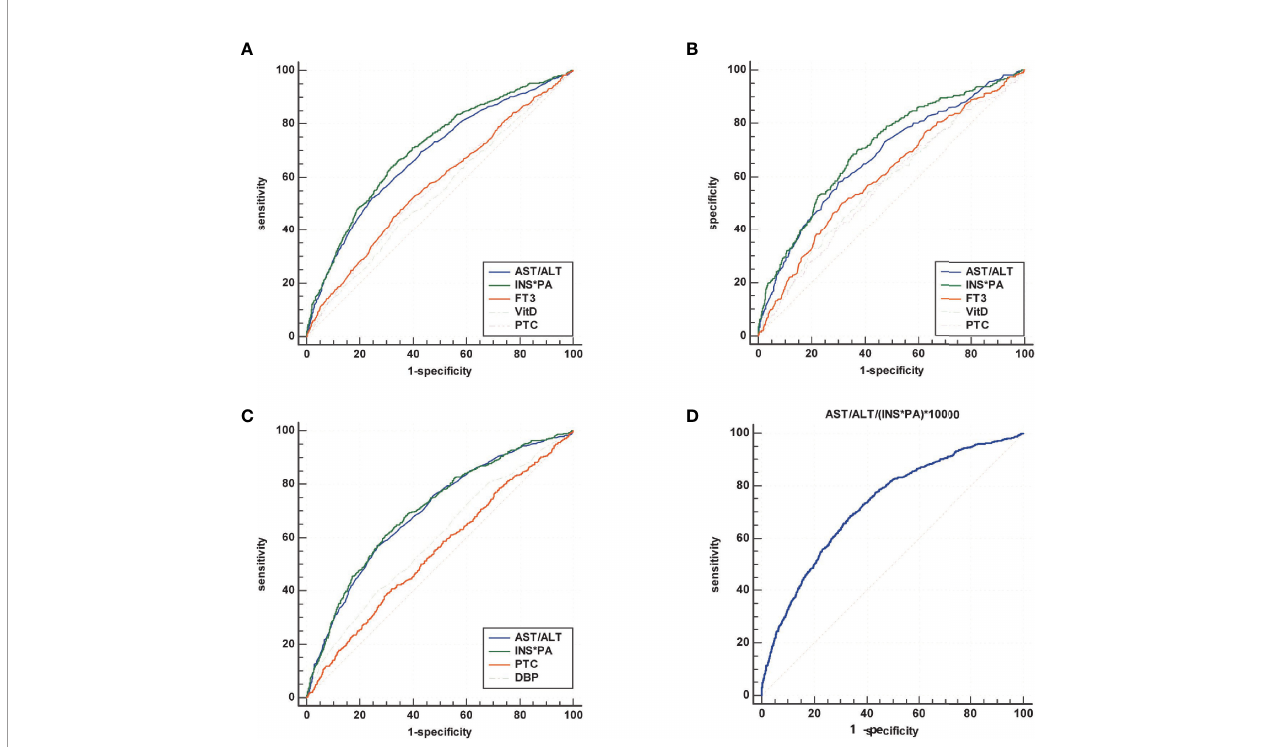
FIGURE 2 | Summary of the results of ROC analysis of various biomarkers for the diagnosis of sarcopenia in all participants (A) , male participants (B) , and female participants (C) , and comprehensive diagnosis in all subjects (D) . The area under the ROC curve (AUC) of the INS*PA was the highest (0.705, 0.706, and 0.701, respectively, P < 0.05), followed by that of AST/ALT (0.680, 0.675, and 0.695, respectively, P < 0.05). In male participants, FT3 and VitD also had certain diagnostic ability, with AUC of 0.606 and 0.583, respectively, but were insigni fi cant in female participants. For PTC, the diagnostic ef fi cacy was limited (0.561, 0.570, and 0.546, respectively, P < 0.05). After dividing the two calculated values, the AST/ALT/(INS*PA)*10,000 was obtained, and the AUC of the new calculated value used to diagnose sarcopenia was